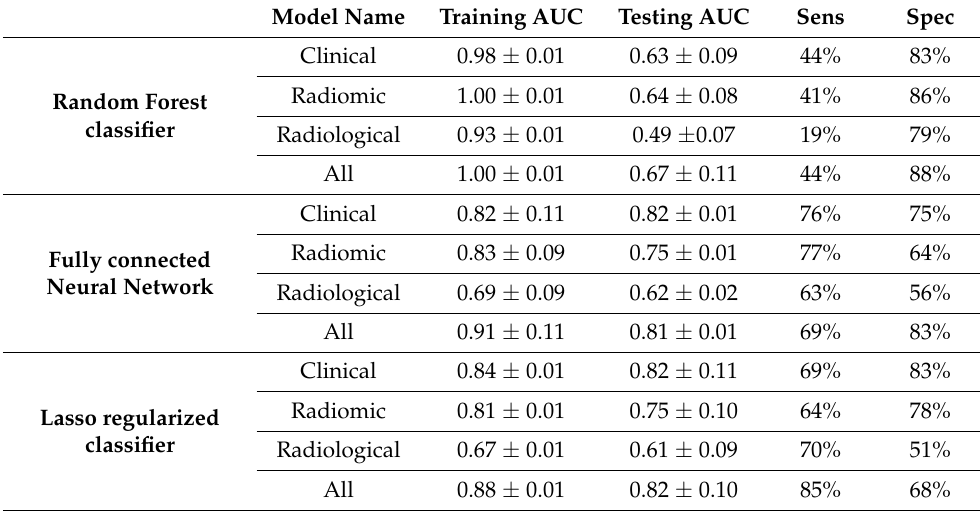
Table 2. Table with all the AUCs obtained using the different models during both training and testing. Sensitivity (Sens) and Specificity (Spec) are relative to the testing phase.